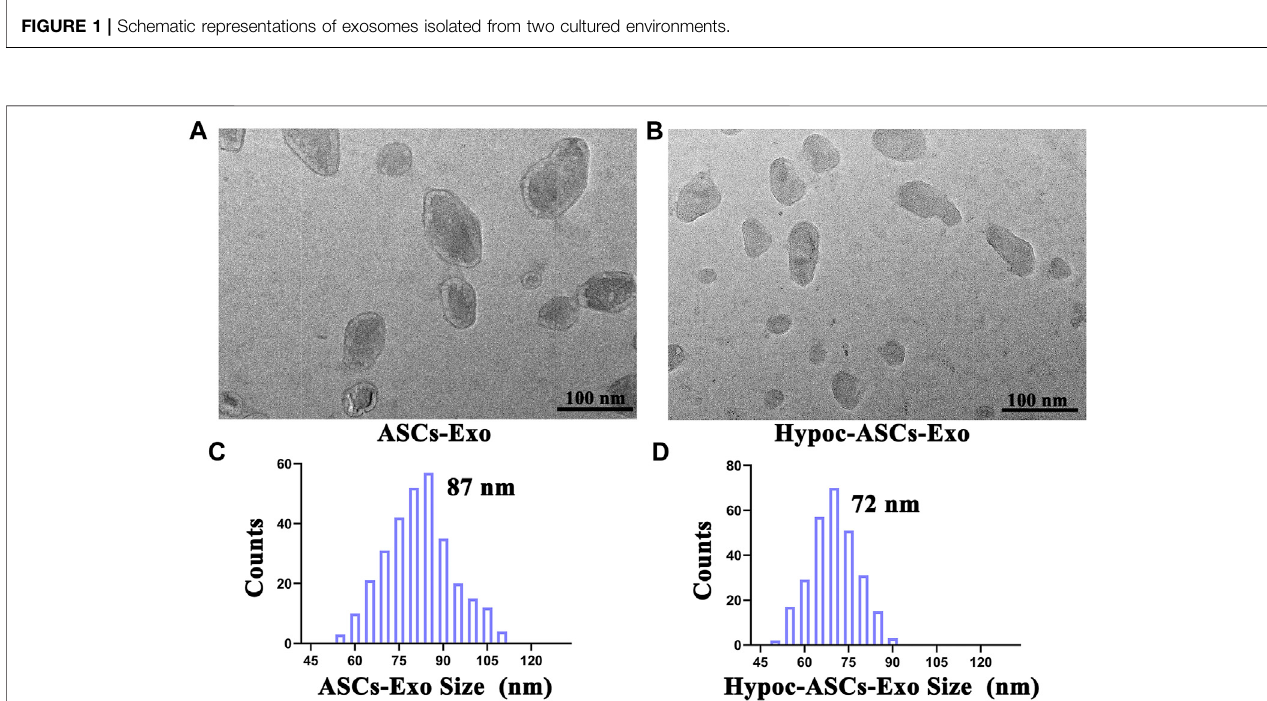
FIGURE 2 | Morphology and diameter distribution of ASCs-Exo and Hypoc-ASCs-Exo. (A,B) Morphology of exosomes were assessed by TEM (scale bars = 100 nm). (C,D) Diameter of the exosomes was assessed by dynamic laser scattering (DLS).